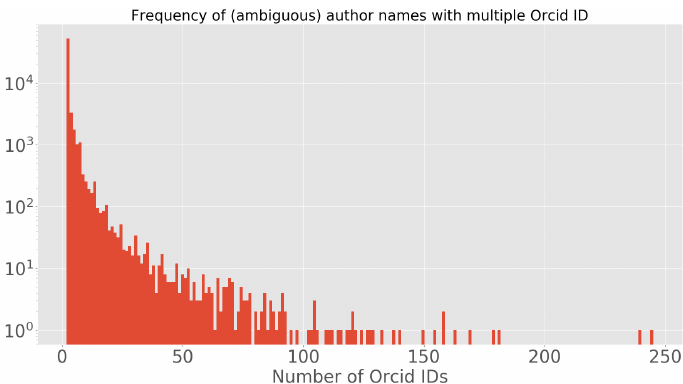
Figure A1. The frequency of ambiguous author names with multiple Orcid IDs. It represents the frequency of names that are shared with distinct authors. ’Wei Zhang’ and ’Wei Wang’ are the most common names, being shared with over than 200 distinct authors each.